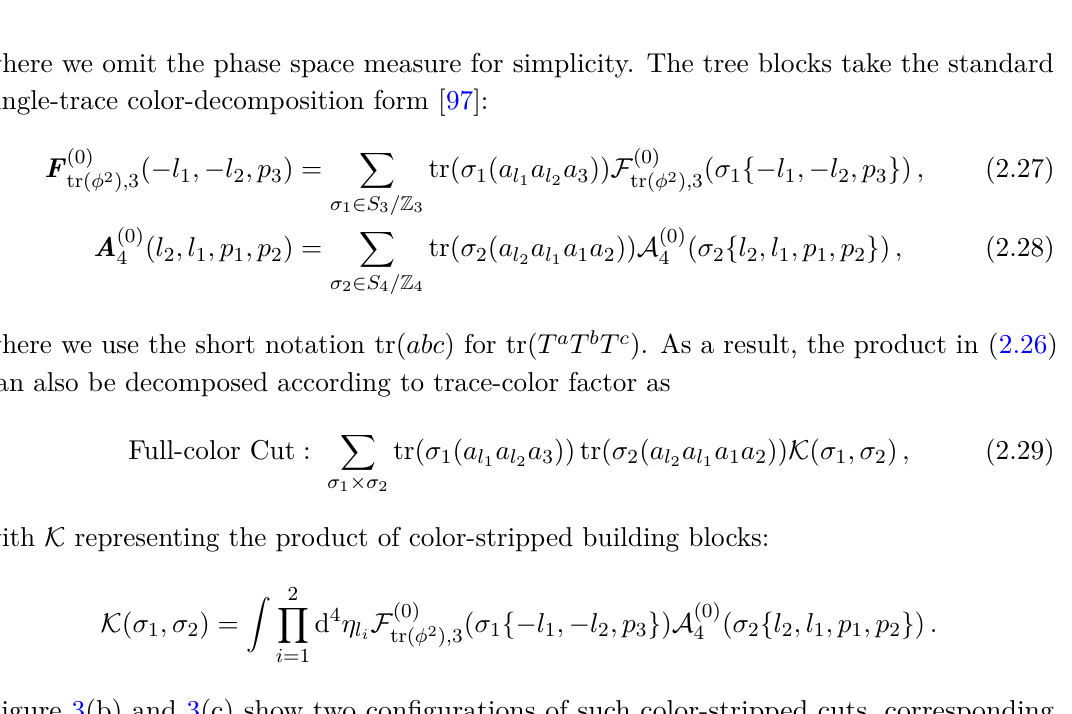
Figure 4. Trivalent graphs contributing to the full-color s 12 cut for one-loop three-point form